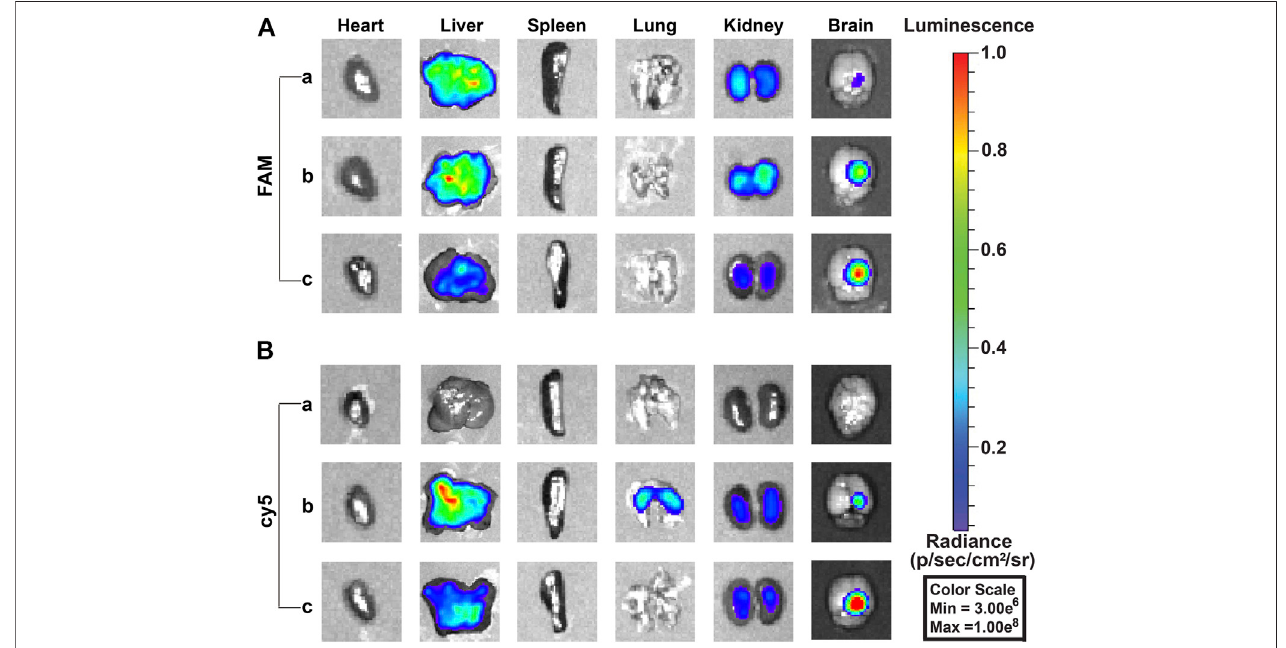
FIGURE 9 | Fluorescence images of siEGFR FAM and TMZ cy5 in organs after intravenous injection of complex nanoparticles (n = 3). (A) Fluorescence image of the FAM channel: (a) free siEGFR FAM , (b) PEG-PAE(SS)/TMZ@siEGFR FAM , and (c) Tf-PEG-PAE(SS)/TMZ@siEGFR FAM . (B) Fluorescence image of cy5 channel: (a) free TMZ cy5 , (b) PEG-PAE(SS)/TMZ cy5 @siEGFR, and (c) Tf-PEG-PAE(SS)/TMZ cy5